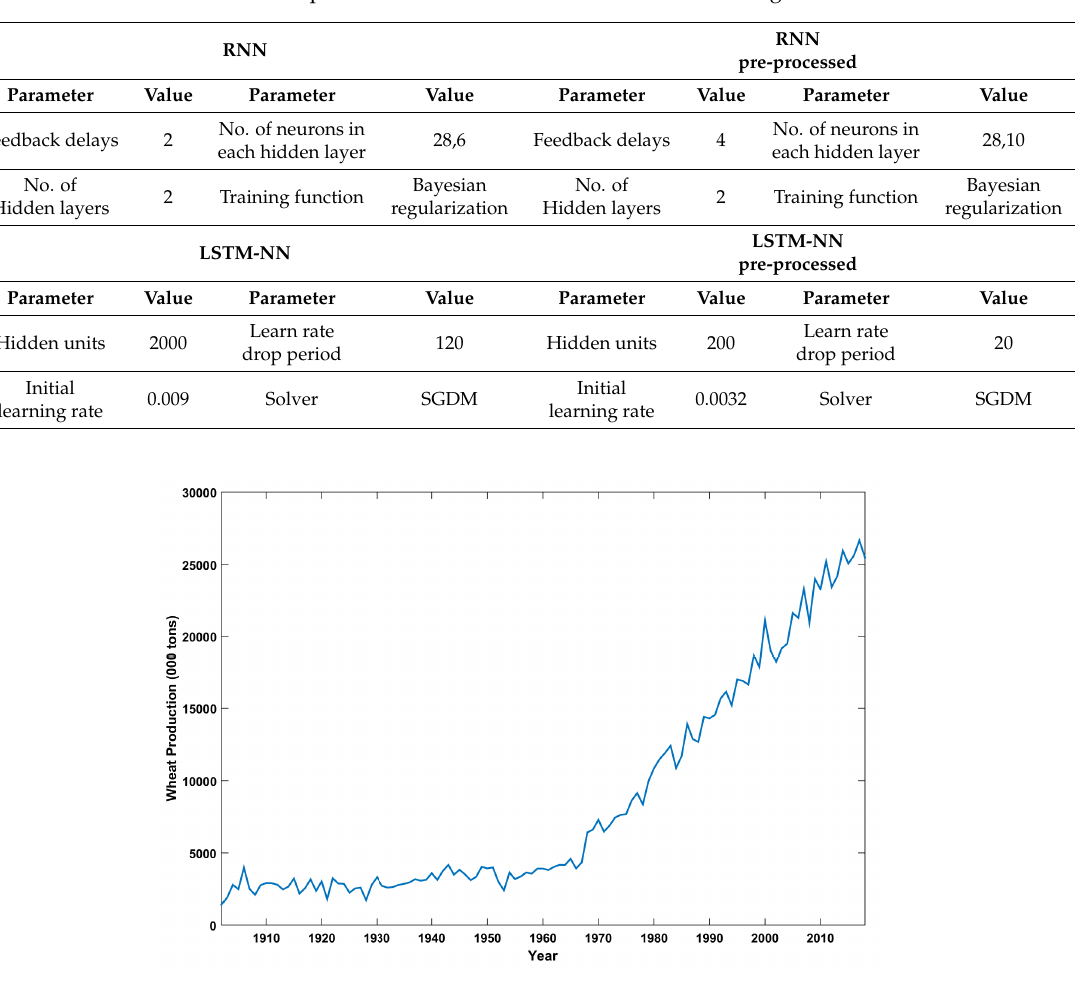
Table 3. Best parameters for RNN and LSTM-NN forecasting models.